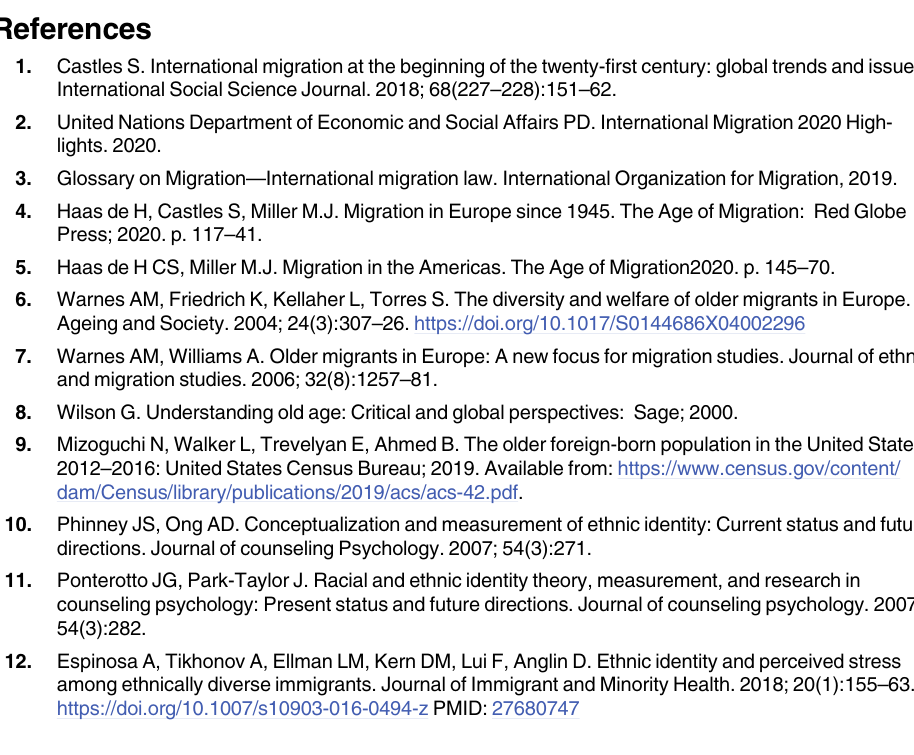
S6 Table. Coded BCT per individual intervention. S7 Table. Intervention effectiveness involving assessment � 3 months post baseline by out- come clusters. S8 Table. Summary of study